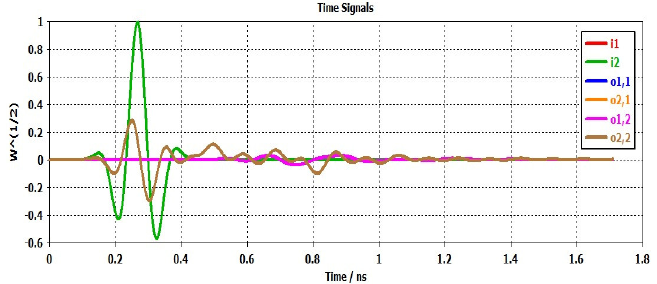
Figure 13. Time–domain response.